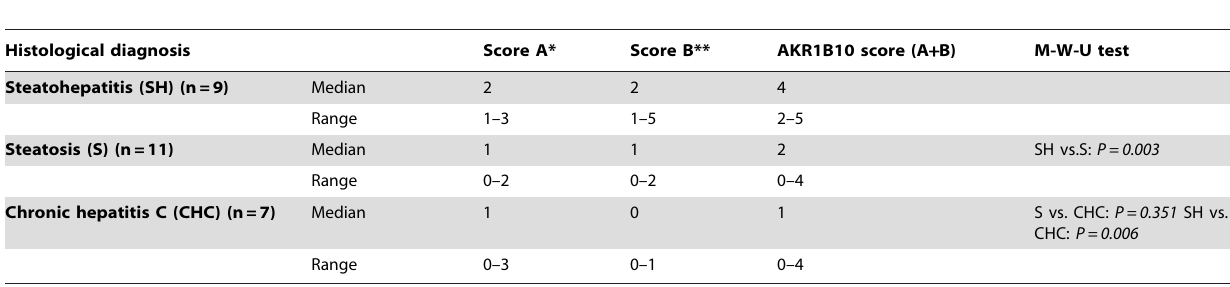
Table 5. Immunohistochemical expression of AKR1B10 in liver parenchyma of patients with steatohepatitis, steatosis and chronic hepatitis C.